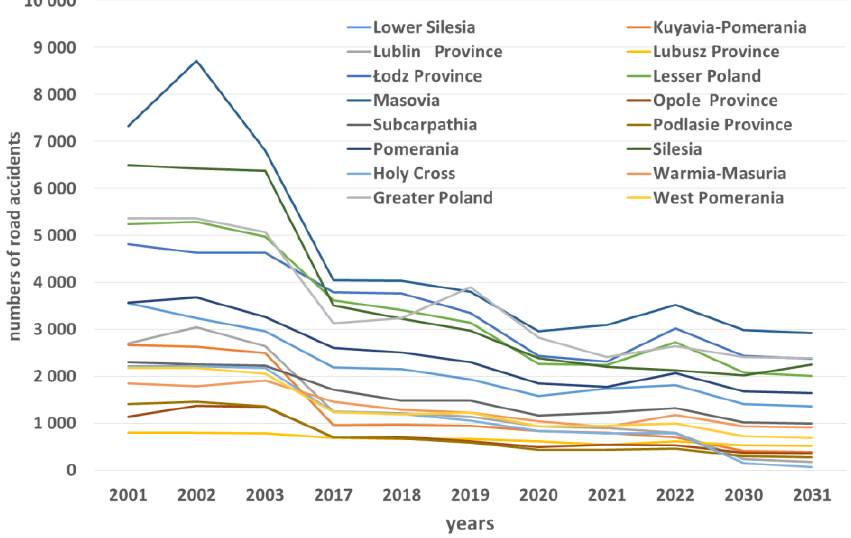
Figure 6. Forecasting annual number of road accidents for 2022–2031.